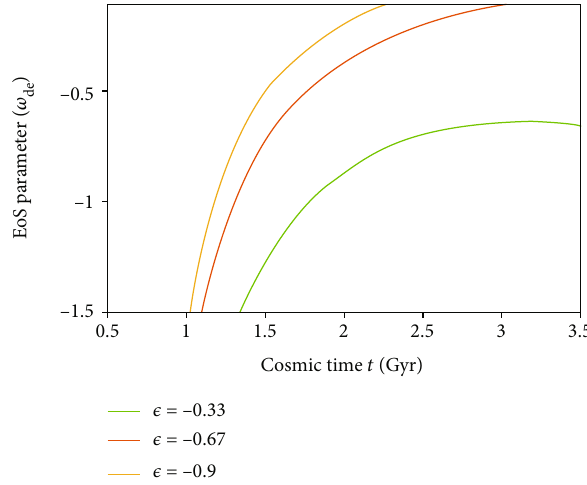
Figure 1: The plot of deceleration parameter ð q Þ versus cosmic time t for ξ = 0 : 5,0 : 6,0 : 7 , b = 0 : 5 , and l = 0 : 6 ,